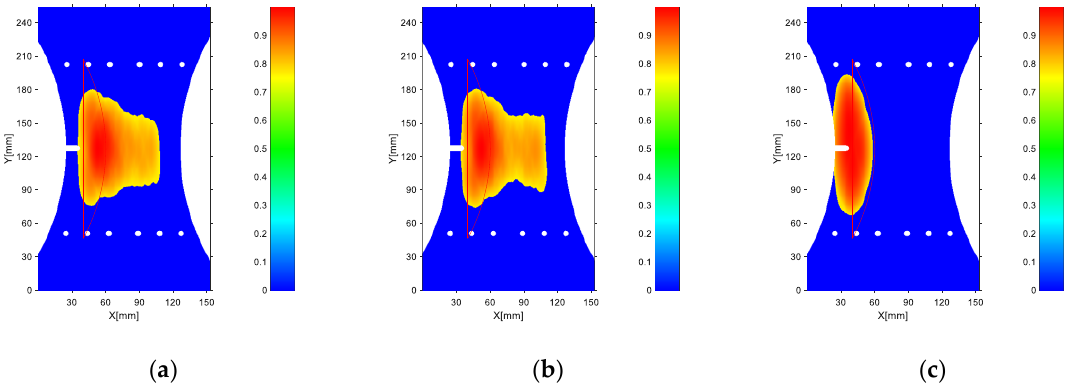
Figure 22. Thresholded imaging with different damage factors at a signal-to-noise ratio of 6 dB: ( a ) energy damage factor; ( b ) cross-correlation damage factor; ( c ) sparse representation damage factor.